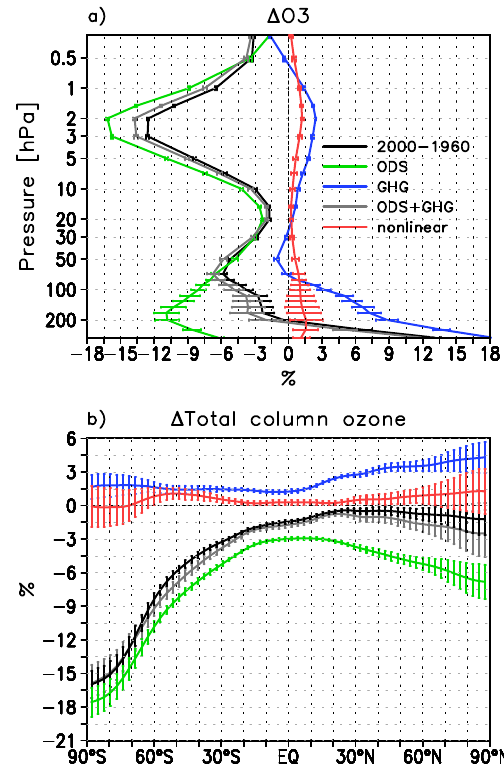
Figure 1. (a) Vertical profile of the annual mean global mean change in ozone mixing ratio (in percent) between 1960 and 2000 (black) and the contributions from GHGs (blue) and ODSs (green) and the nonlinear term (red). The sum of the single forcings (GHG + ODS) is shown in grey. The bars denote the 95% con- fidence level of the changes. (b) Same as (a) but for the latitude dependant annual mean change in total column ozone (in percent) between 1960 and